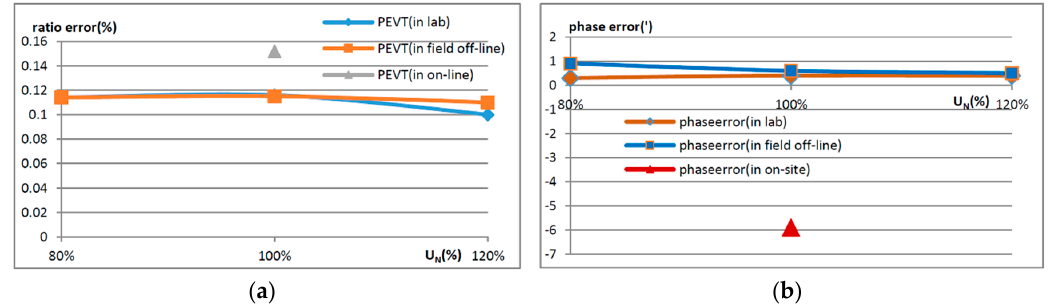
Figure 12. Error comparison of OVT under the three conditions of lab, in the field off-line and during on-line operation. ( a ) The ratio error comparison of OVT; ( b ) The phase error comparison of OVT.